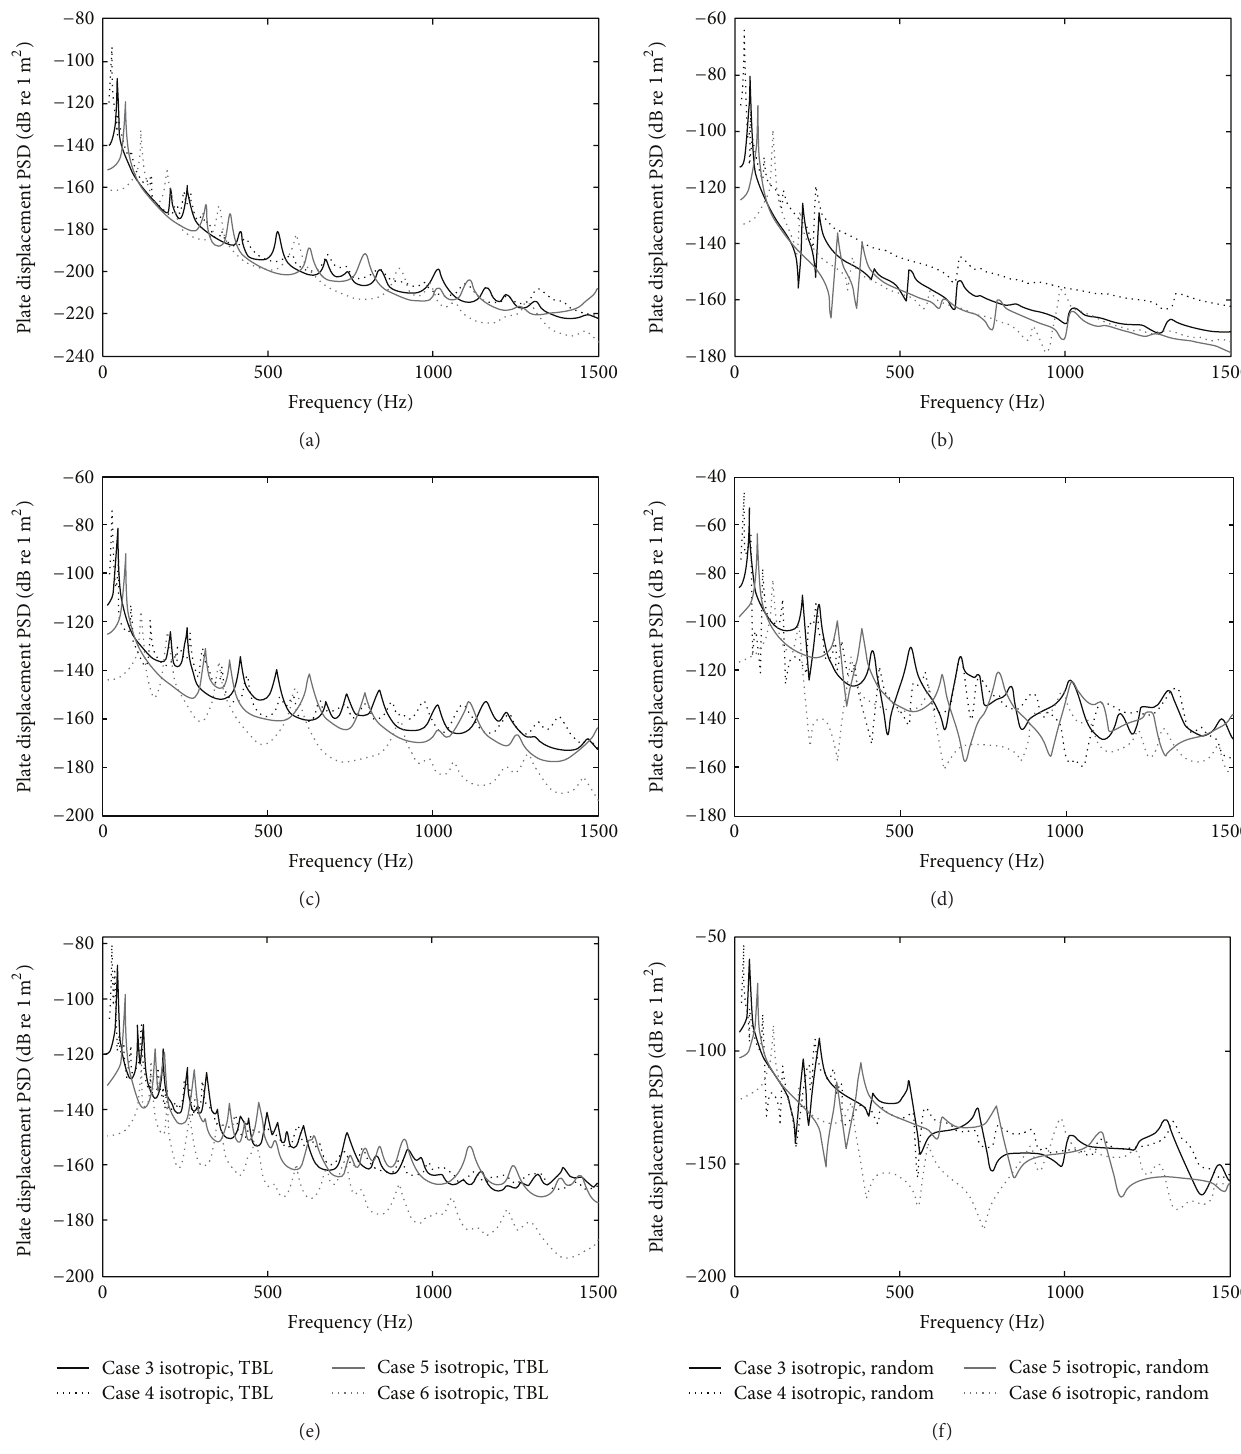
Figure 7: Panel displacement PSD results for the isotropic panels: (a) and (b) overall panel 𝑆 𝑤𝑤 ; (c) and (d) 𝑆 𝑤𝑤 near surface location (𝑥 1 ,𝑦 1 ) = (𝑥 , 𝑦 ) = (0.3𝑎,0.2𝑏) (0.5𝑎, 0.5𝑏) ; (e) and (f) 𝑆 𝑤𝑤 near location 2 2